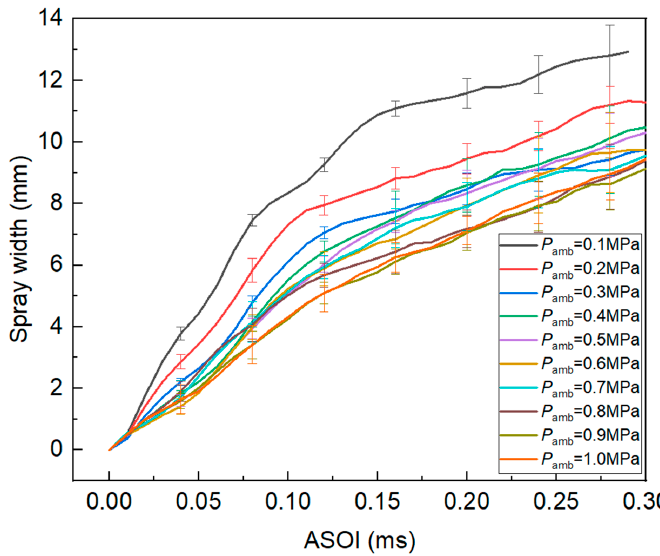
Figure 11. Spray width in flash boiling conditions, P inj = 100 MPa; fuel: liquid